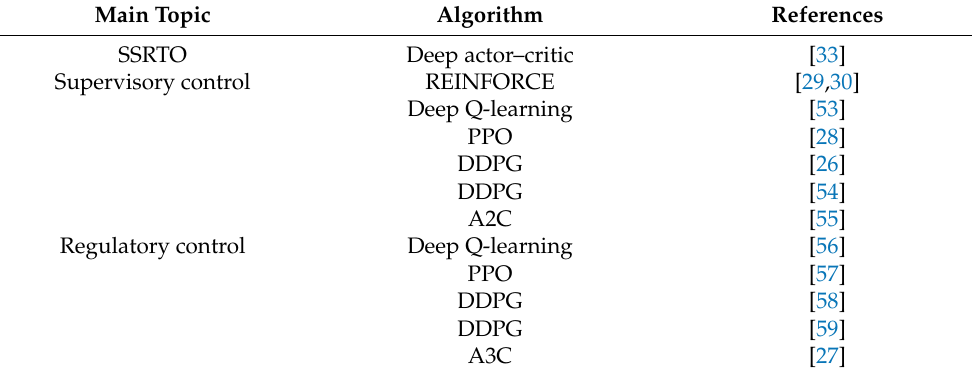
Table 1. Several references for reinforcement